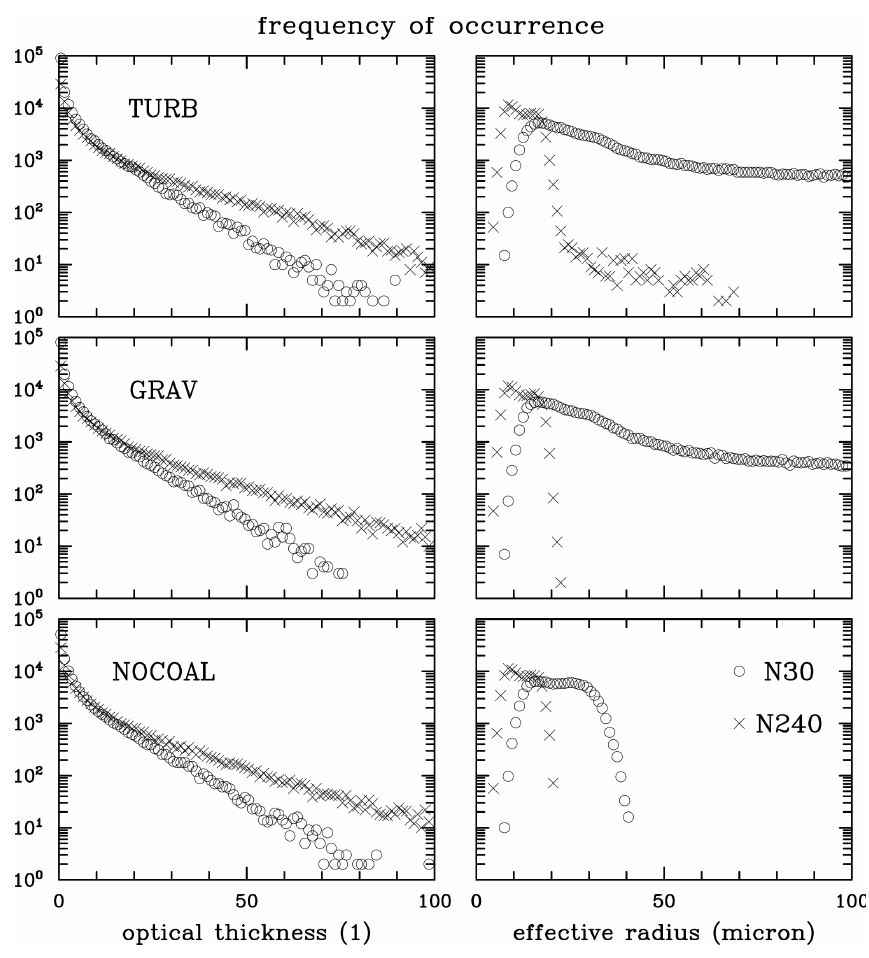
Figure 8. Frequency of occurrence of the optical thickness (left panels) and column effective radius (right panels) for last 3h of N30 and N240